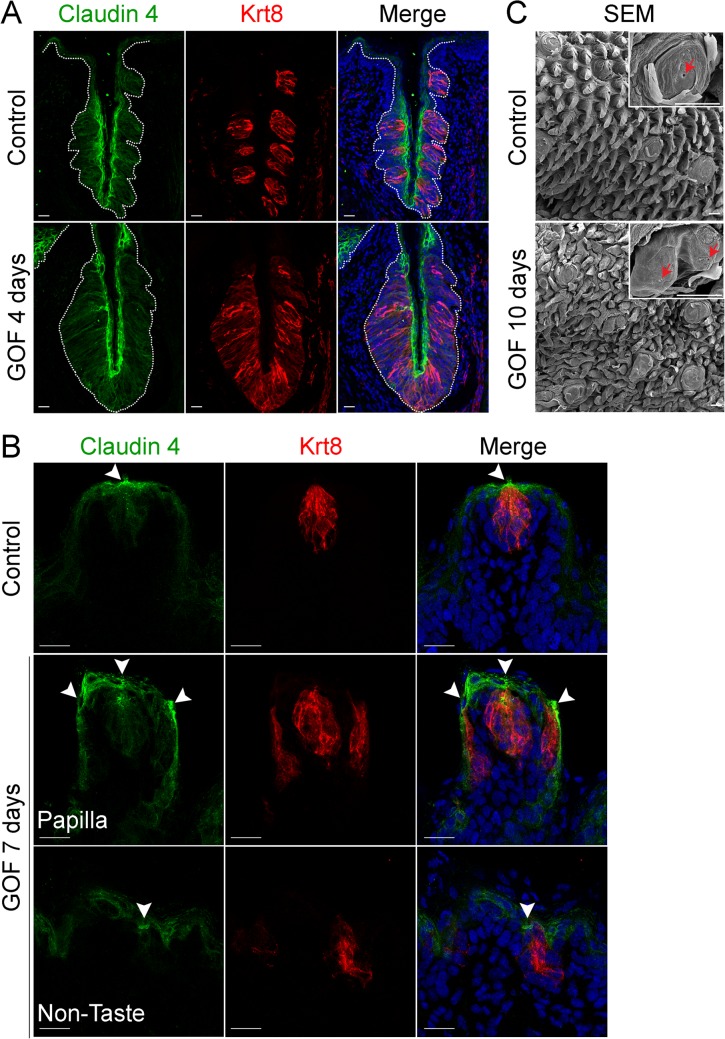
Expression of Claudin4 and evidence of taste pores suggests appropriate cell contacts are induced and maintained in mutant taste buds with stabilized β-catenin.Claudin4 is a tight junctional protein expressed specifically by control taste buds (A,B control). Claudin4 expression was maintained and expanded in mutant CVP taste epithelium (A, GOF 4 days, dotted line), and by ectopic taste buds in the FFP and non-taste epithelium (B, GOF 7 days, arrowheads). FFP in controls have a single taste pore shown via SEM (C, Control, red arrowhead), whereas in mutants treated with dox for 10 days, we encountered FFP with duplicated taste pores (C, GOF 10 days, red arrowhead). NB: red staining in the mesenchyme in A is due to non-specific secondary antibody binding. Nuclei were counterstained with DRAQ5 in blue. Three mice were used in each experimental group. Dotted line delineates the basement membrane. Scale bars = 20 μm in A,B and 30 μm in C.